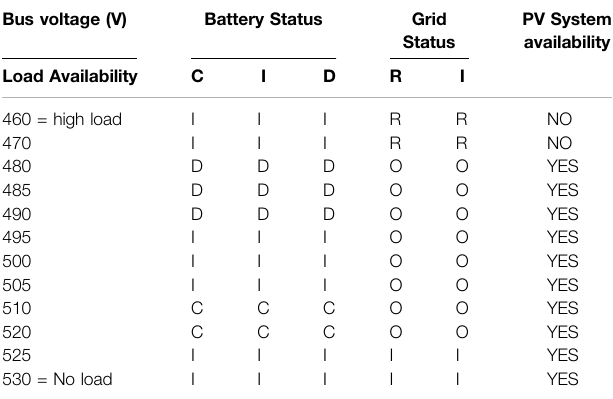
TABLE 4 | System rule of fuzzy logic controller. Bus voltage (V)